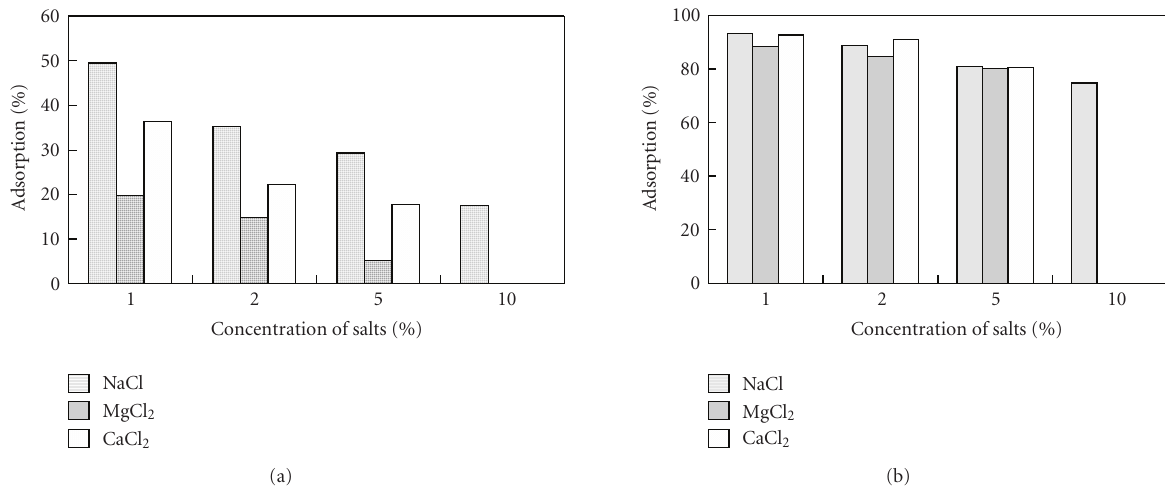
Figure 2: E ff ect of macrosalts on the biosorption performance: (a) Influence on the biosorption of Cd(II); (b) influence on the biosorption of